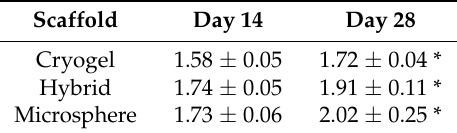
Table 1. The Ca to P atomic ratio of deposited minerals in the cryogel scaffold, the cryogel part in the hybrid scaffold and the microsphere cavity in the hybrid scaffold after in vitro culture for 14 and 28